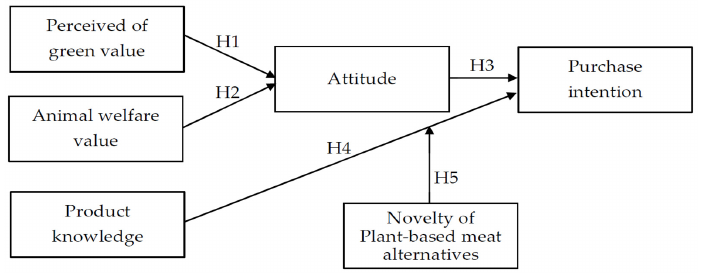
Figure 1. Research framework. Table 2. Constructs/variables and corresponding measuring statements are included in the ques- tionnaire.